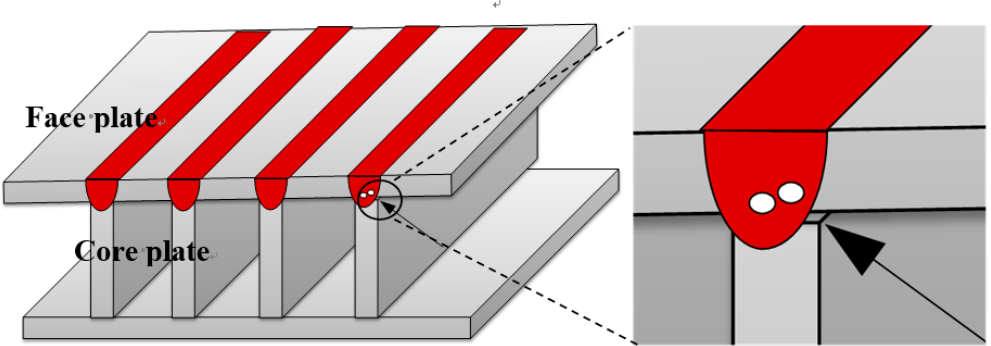
Figure 1. Schematic of sandwich structure.